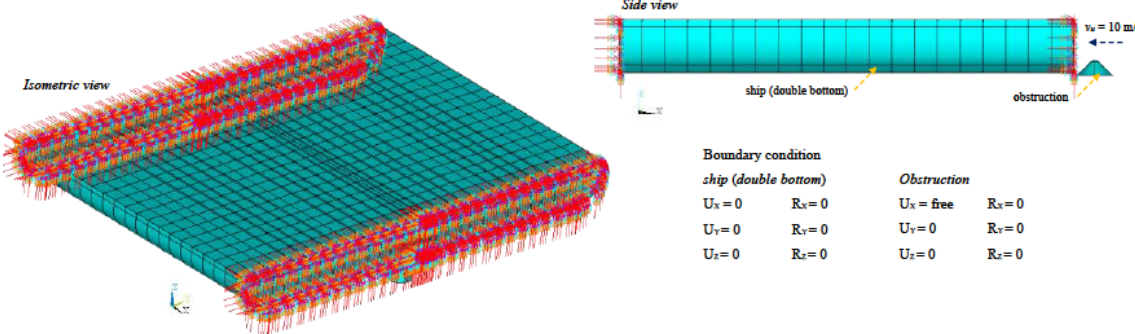
Figure 4: Illustration of boundary condition (left side) and grounding process (right side). The ship and obstruction are highlighted by ar- rows on the side view.